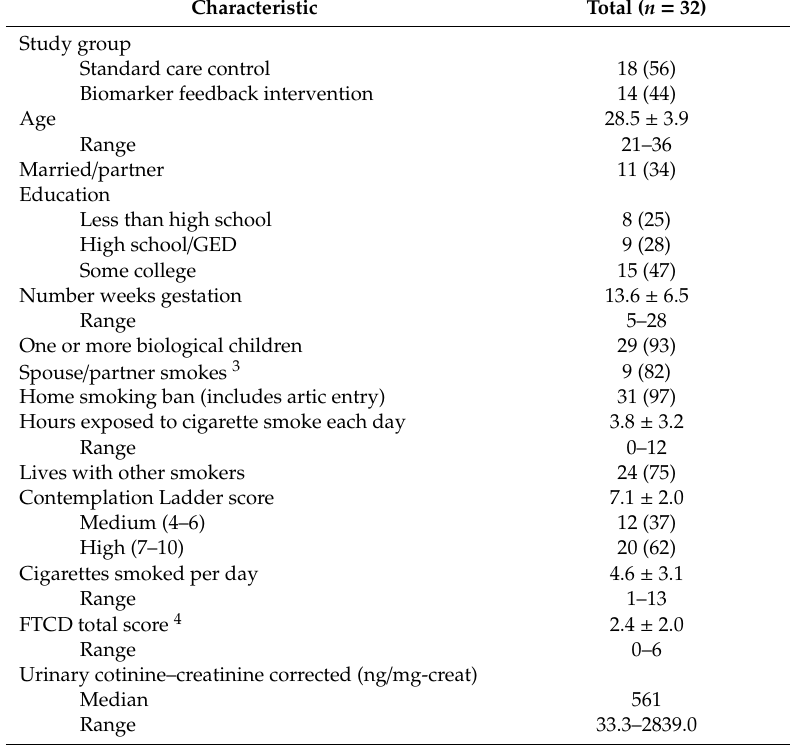
Table 1. Participant socio-demographic and tobacco use characteristics: MAW Phase 4 study 1,2 .